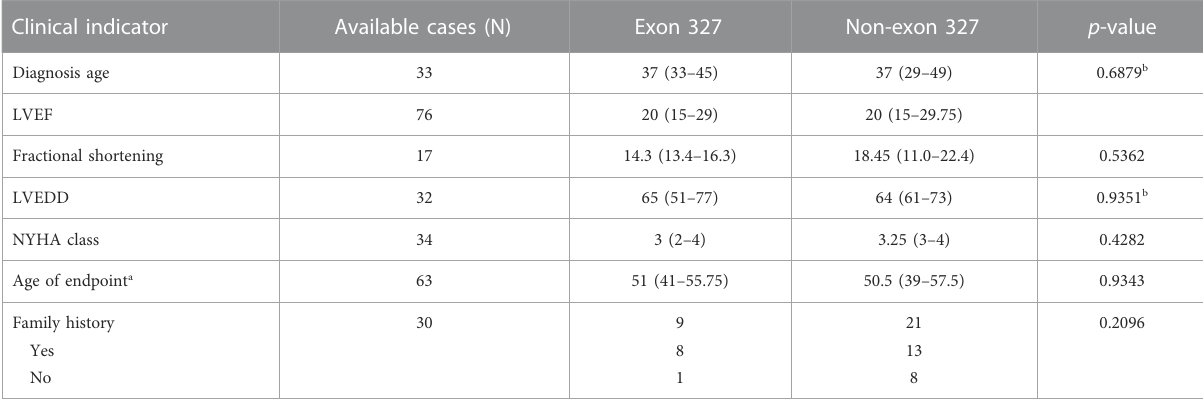
TABLE 3 Phenotype comparison of exon 327 TTNtv and non-exon 327 TTNtv. Clinical